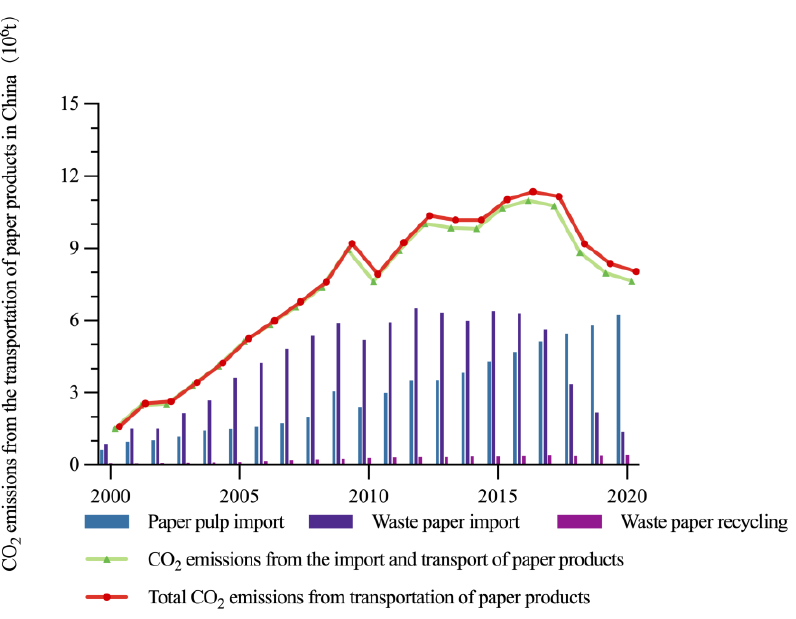
Figure 5. CO 2 emissions from the transportation of Chinese paper